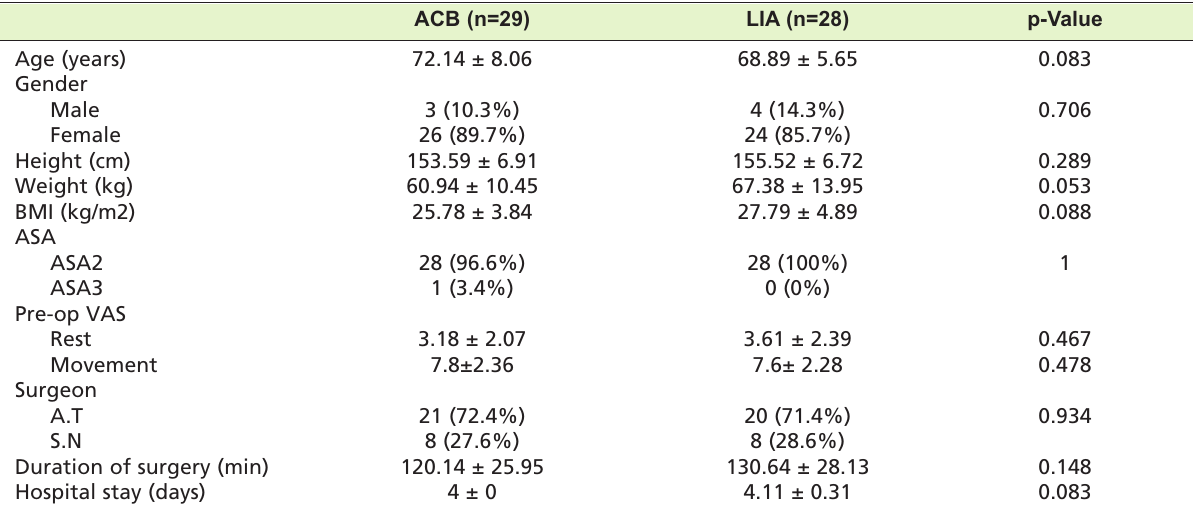
Patient characteristics Table I: